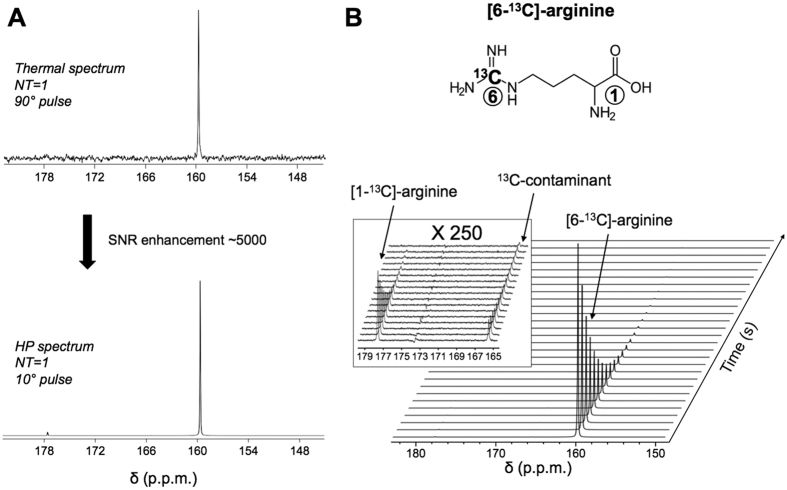
[6-13C]-arginine can be hyperpolarized.(A) [6-13C]-arginine thermal equilibrium spectrum (top) and hyperpolarized spectrum (bottom) acquired at 11.7 Tesla showing the ~5000-fold SNR enhancement by the dissolution dynamic nuclear polarization technique (NT = number of transient). (B) Stack plot of 13C MR spectra of hyperpolarized [6-13C]-arginine in solution acquired at 11.7 Tesla showing decay of the hyperpolarized signals (temporal resolution 3 s). Resonances of [6-13C]-arginine (δ[6-13C]-arginine = 159.7 ppm), [1-13C]-arginine (δ[1-13C]-arginine = 177.1 ppm, originating from 1.1% 13C natural abundance at C1 position), 13C-contaminant (at the same resonance of urea, δ[13C]-urea = 165.5 ppm, and that could originate from 1.1% 13C natural abundance of urea contaminant) were detectable.